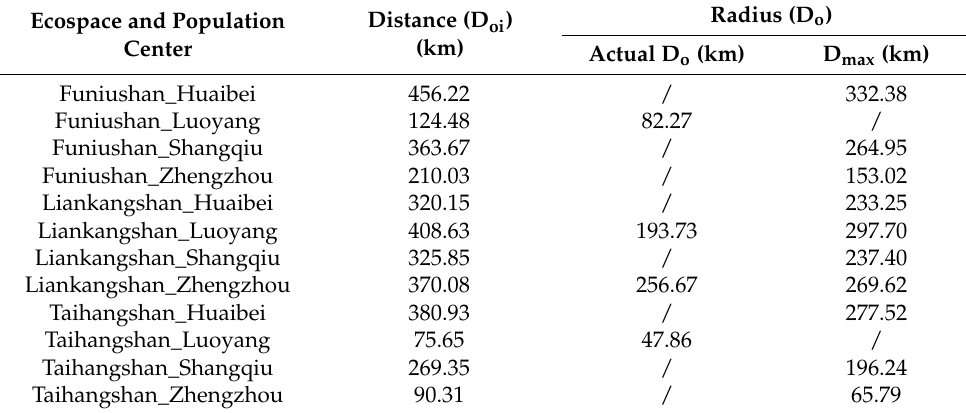
Table 7. Distance and radius of ecospace and population center.